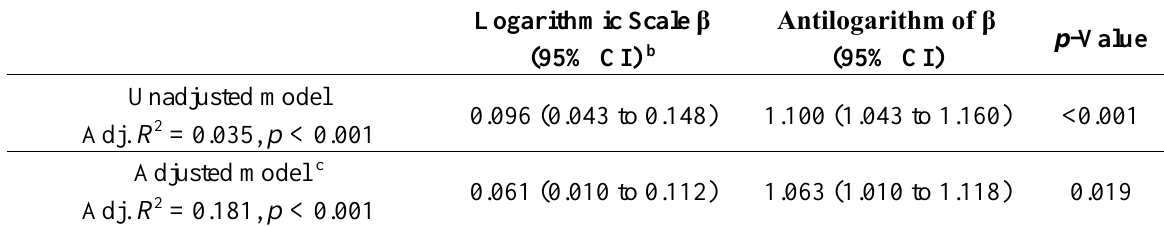
Table 6. Multiple regression analysis of associations between serum ferritin and serum zinc concentrations in women aged 18–50 years ( N = 326) a